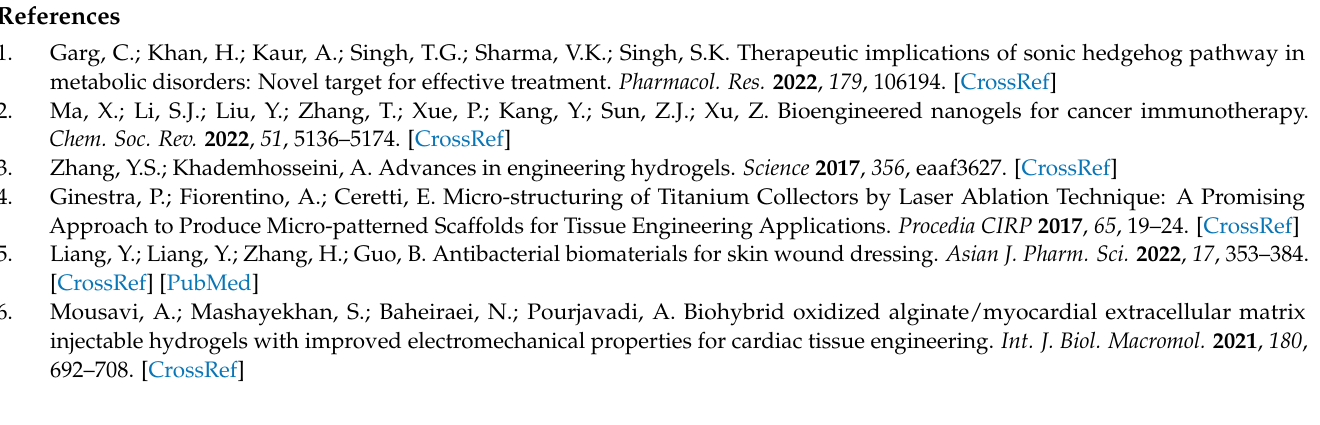
Table S1: Details of the instruments used in this